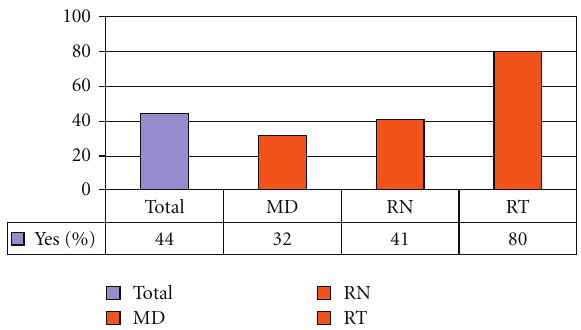
Figure 11: Found Emergency Airway Form helpful in the situation?